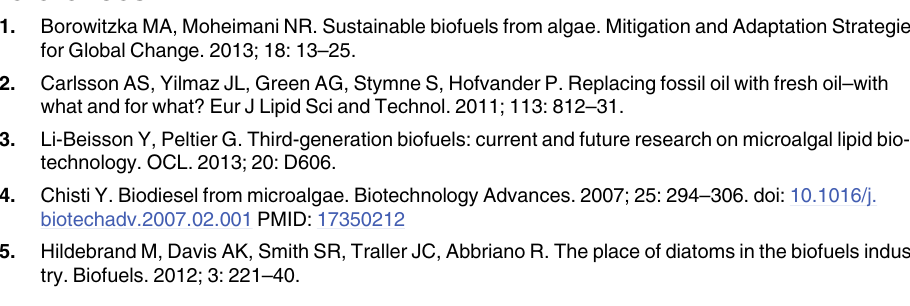
S5 Table. Raw data table of analytes. Trimethylsilyl (TMS) and methoxyamine (MEOX) derivatives of the metabolites were analysed by GC-MS. Samples were measured in two (time- point 0 d) or three biological replicates (all other samples). Values were calculated from the integration results using the quantification mass to charge ratio (quant m / z ) at the retention time (RT) depicted in the analyte sheets. The retention index (RI) was calculated based on an alkane standard. Values were divided by the value of the internal standard (Ribitol 5TMS) and the dry weight. For ribitol, the integral of the given m / z is depicted. In the case the metabolites were represented by more than one analyte the values were added based on the total ion